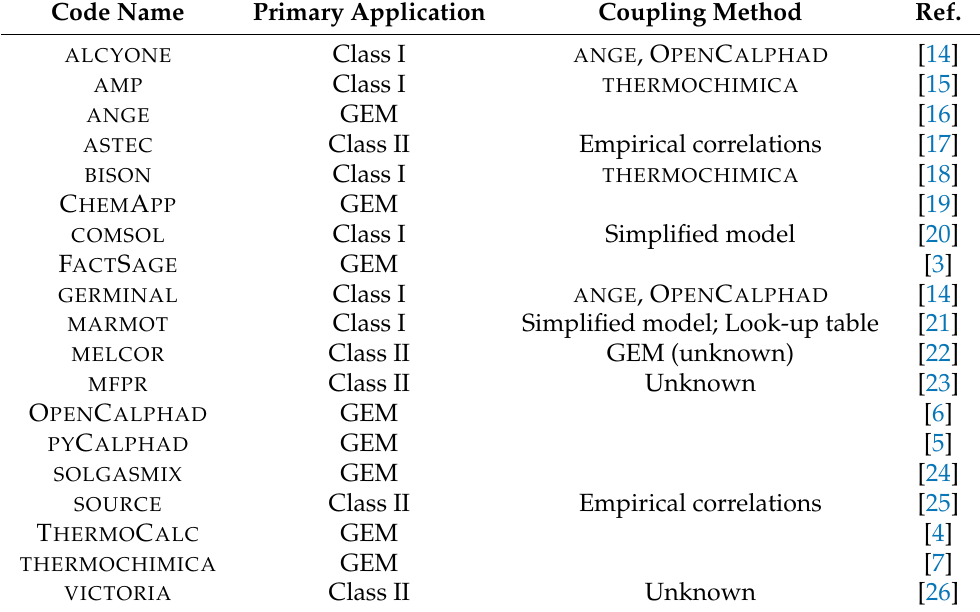
Table 1. A summary of relevant codes mentioned in this article. GEM = Gibbs Energy